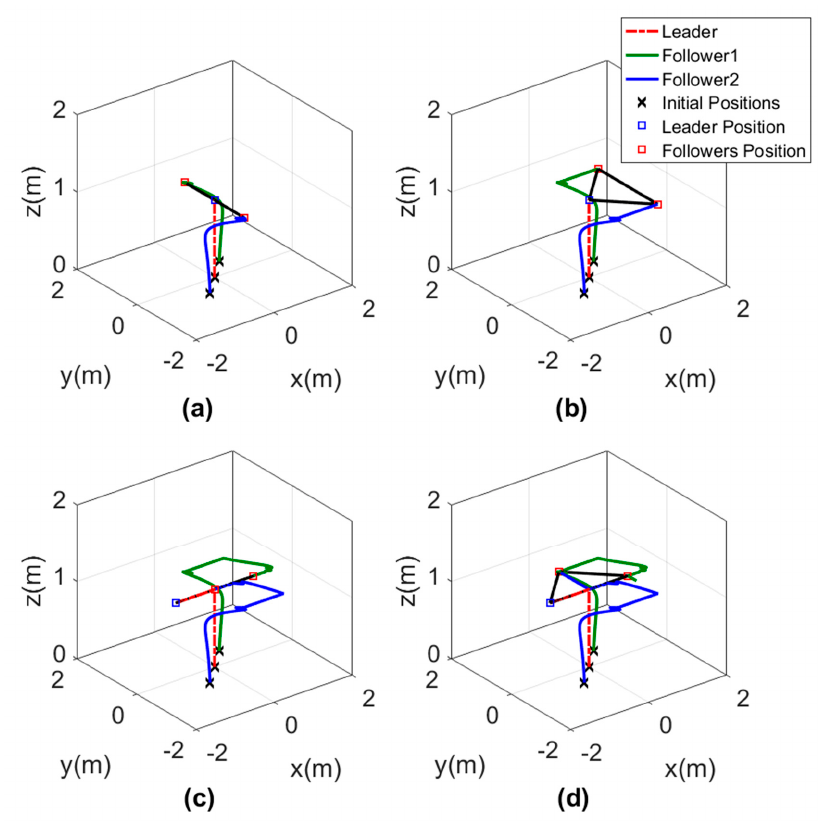
Figure 19. Three-dimensional views of switching formation topology, ( a ) Agents formation at t = 25 s. ( b ) Agents formation at t = 50 s. ( c ) Agents formation at t = 75 s. ( d ) Agents formation at t = 100 s.